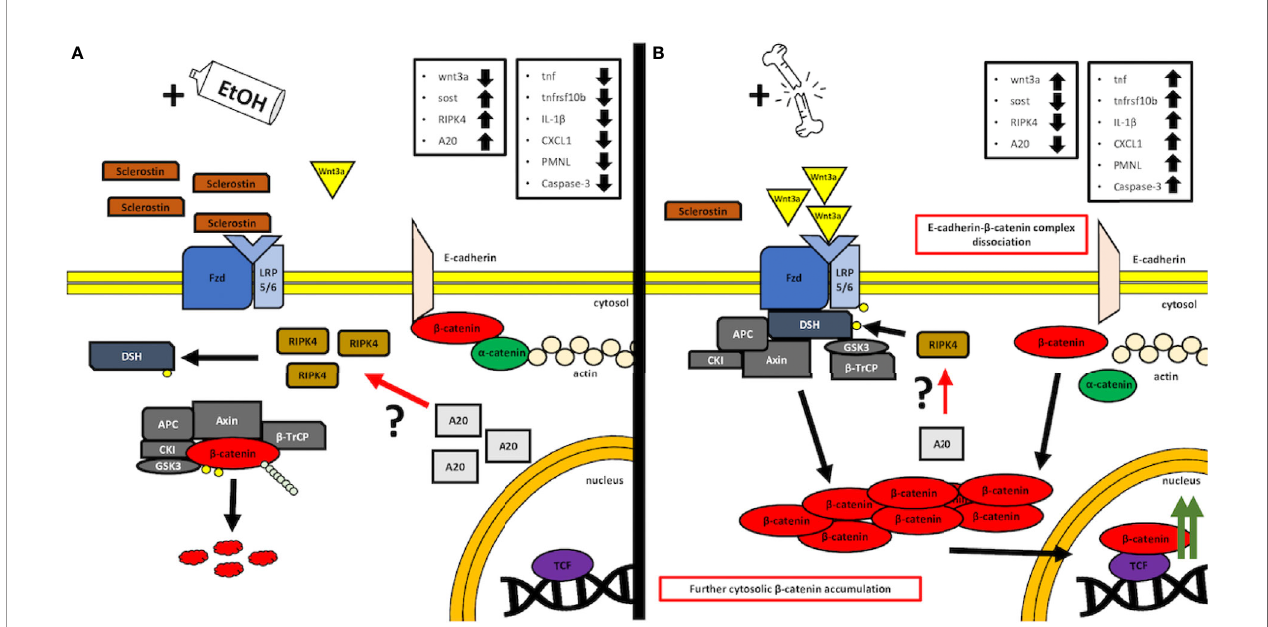
FIGURE 7 | A simpli fi ed, graphical depiction of the regulation mechanism of the Wnt/ b -catenin signaling by the acute ethanol intoxication (EI) (A) and with the major trauma injury (B) . (A) Suspected mechanism of the EI in fl uence over the activity of the canonical Wnt/ b -catenin. According to our fi ndings, we observed that acute alcohol intake leads to the elevated levels of Sost gene expression, whose product, sclerostin, acts as a natural competitor inhibitor for Wnt receptors. Additionally, we noticed increased expression levels of both receptor-interacting protein kinase 4 (RIPK4) and A20 protein in the same EI setting. Interestingly, it was reported before that RIPK4 appears to be a positive regulator of canonical Wnt/ b -catenin signaling, while A20 protein seems to be the natural inhibitor of RIPK4 activity and presumably regulates the Wnt/ b -catenin signaling through this kinase (12). In our fi ndings, the upregulated levels appear to be contradictory to these results; however, both levels of A20 and RIPK4 seem to compensate each other, and thus, one may suspect an interaction between those, which cancels the RIPK4-upregulating activity, as the Wnt/ b -catenin- driven trauma-induced in fl ammation is suppressed compared to the ctrl group. However, further investigation is required, especially on the fi eld of the base protein expression and gene transcription and the involvement of the alcohol as a potential regulator of A20 – RIPK4 interplay. (B) Trauma-based breakdown of the lung barrier through the positive regulation of Wnt/ b -catenin signaling in the presence of alcohol. The major trauma injury affects the internal sclerostin and wnt3a ligand competition of the Fzd and LRP-5/6 receptor by favoring the expression of the latter, thus stimulating the destruction complex disruption and b -catenin release to the cytosol. In addition, b -catenin appears to dissociate from E-cadherin-based AJ (adherens junction) complexes, thus disrupting the cell – cell interactions of epithelial cells. At the same time, the expression levels of A20 and RIPK4 seem to decrease; however, it is unknown if this downregulation in fl uences the withdrawal of the destruction complex from the cytosol or maybe it is a time-dependent interaction that requires kinetics-based observations, so that the fold change in time of both molecules during the transition between off and on states can be followed. APC: adenomatous polyposis coli, AXIN: the axis inhibition protein scaffold protein, b TrCP: the beta-transducin repeat containing protein, CKI: casein kinase, Fzd: frizzled protein, GSK3 b : glycogen synthase kinase 3 b , LRP 5/6: low-density lipoprotein receptor-related protein